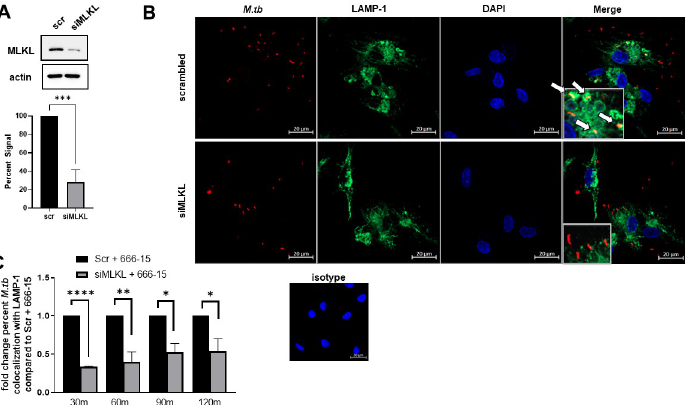
Fig 10. MLKL is essential for phagolysosomal fusion in the absence of CREB signaling in M . tb -infected human macrophages. MDMs were plated on glass coverslips and transfected with siRNA targeting MLKL or scrambled control siRNA for 48h. MDMs were then pretreated for 60 min with CREB inhibitor 666–15 and infected with mCherry M . tb H 37 R v (red) MOI 10. A) Knockdown of MLKL was verified by WB and percent signal quantified relative to scrambled control. A representative experiment is shown and graphed data are cumulative of n = 3 donors. Unpaired t test. B) MDMs were fixed, permeabilized, and stained for LAMP-1 (green) and DAPI (blue). A representative experiment is shown of n = 3 donors. C) At the indicated time points, the percent of M . tb colocalizing with LAMP-1 was calculated following manual counting. Data are shown as fold change of percent colocalization compared to scrambled control for each time point. White arrows indicate colocalization. Data are cumulative ± SEM of n = 3 donors. Unpaired t test; * p < 0.05, ** p < 0.01, *** p < 0.001, **** p < 0.0001.